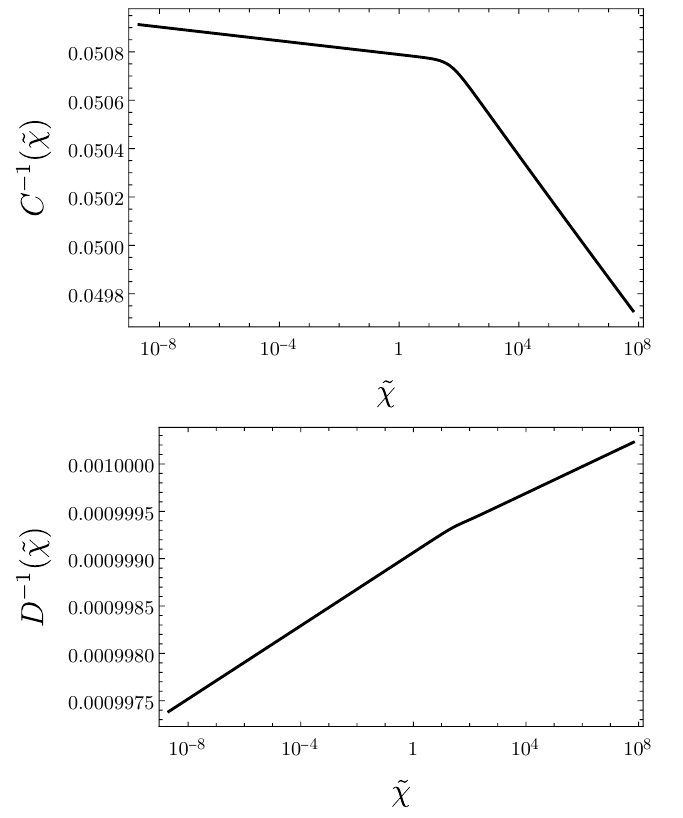
Figure 4 . Critical trajectory (scaling solution) of C − 1 (top) and D − 1 (bottom). These trajectories are for N S = 1 , N V = N F = 0 with initial conditions described in the text.